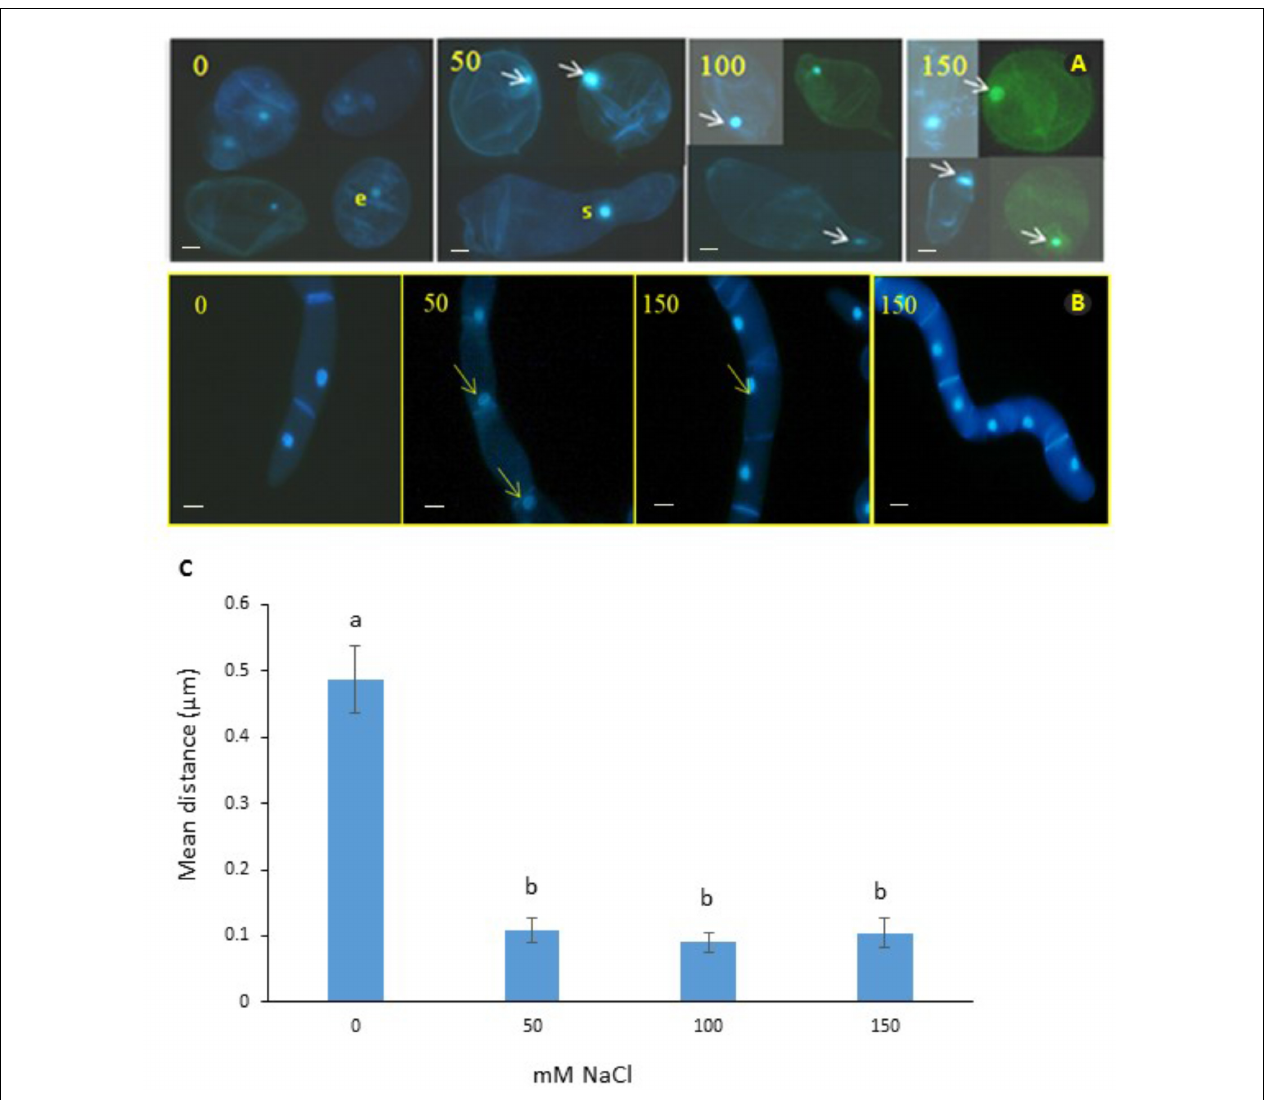
FIGURE 2 | Nuclear positioning in cell suspensions of M. truncatula (A) and N. tabacum (B) at different concentrations of salt (mM NaCl). Arrows show migration of the nuclei to the cell wall and elongation of cytoplasm in the 50 and 100 mM NaCl treatments. It is unlikely that this cellular phenotype has embryogenic potential; e, denotes a small cell with a small nucleus in the 0 mM NaCl treatment that might have embryogenic potential; and s, indicates septum forming along the presumptive cell plate of a cell undergoing cytokinesis. Bar scale = 20 µ m. (C) Position of nucleus in M. truncatula cells exposed to NaCl (0–150 mM). Means of six measurements from nuclear envelope to cell wall for each cell + SE; n = 13–19 cells (see Supplementary Figure 1 ). Different letters indicate significantly different means (Kruskal Wallis followed by a Dunn’s test, P <